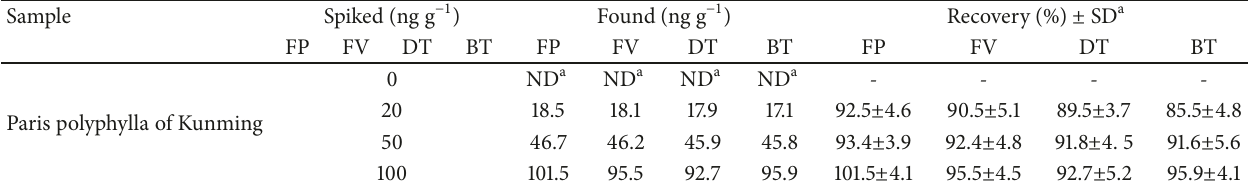
Table 2: Mean concentrations (ng g −1 ) of pyrethroids found in Paris polyphylla sample of Kunming, and recoveries (%) obtained after spiking the samples with FP, FV, DT, and BT at three concentration levels.